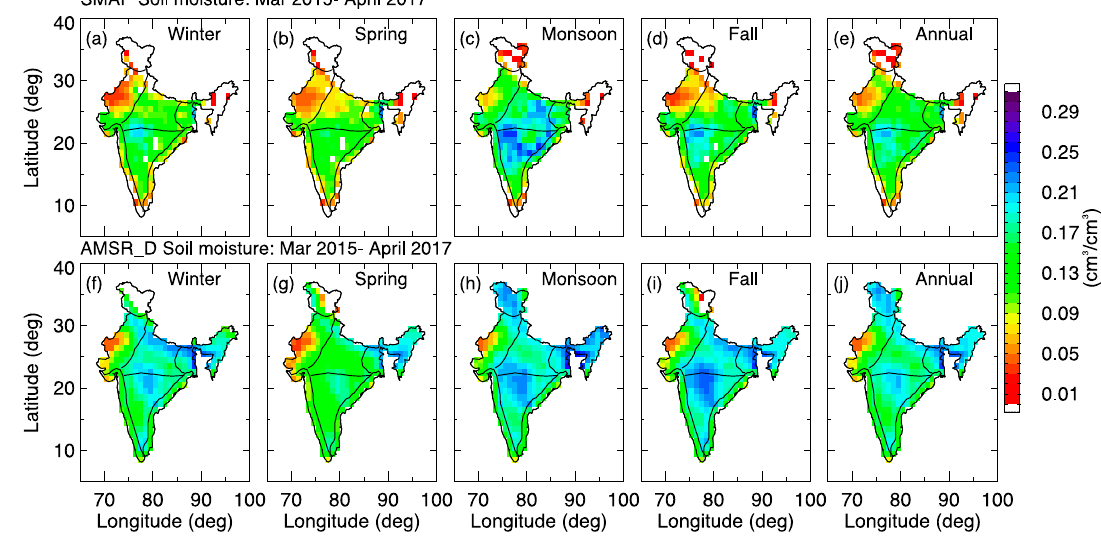
Figure 2. Seasonal and annual climatological soil moisture from SMAP (top panels) and AMSR (bottom panels) in India from March 2015 to April 2017.